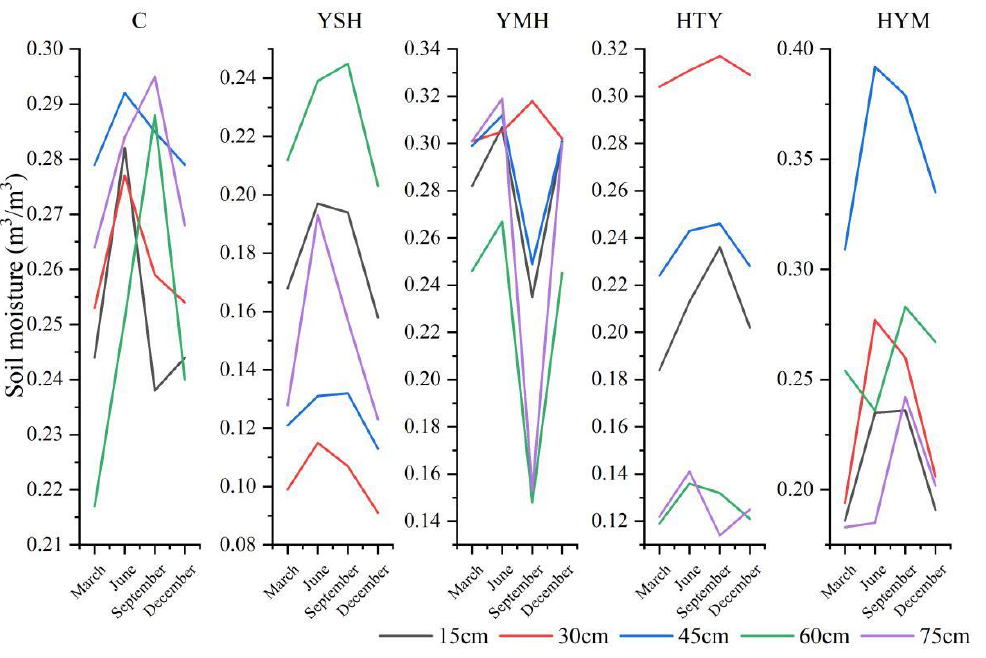
Figure 7. Seasonal variation trend of soil moisture.